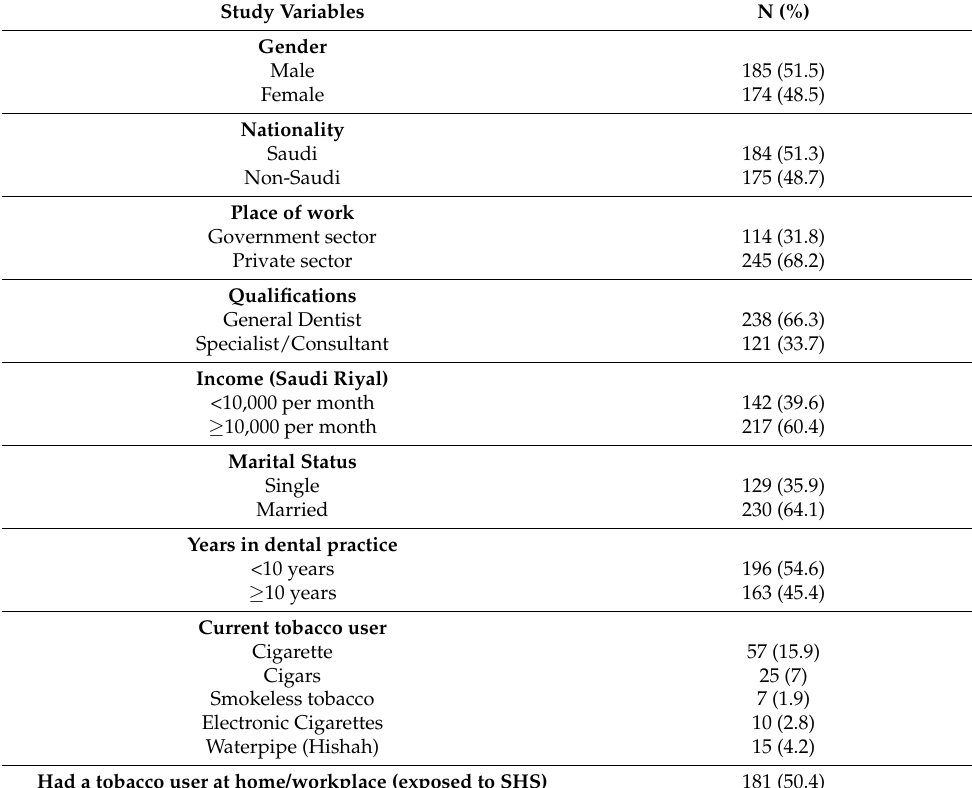
Table 1. Characteristics of study participants (N =